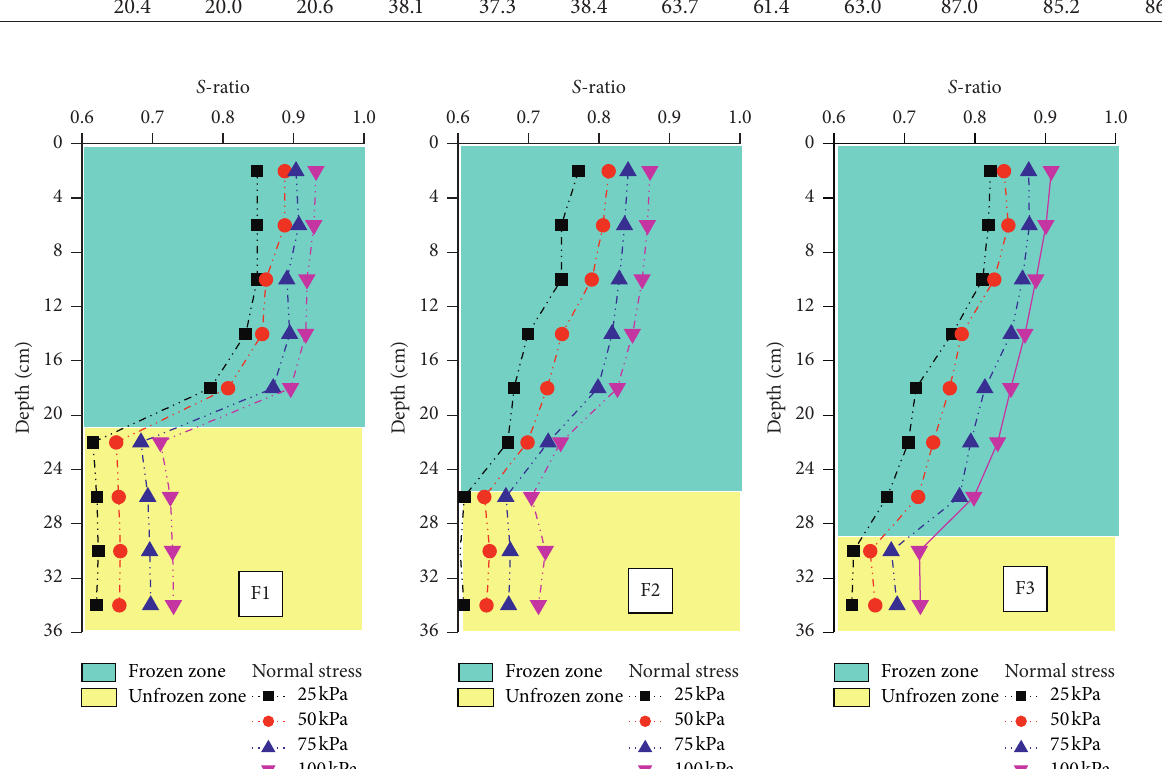
Figure 7: Shear strength ratio ( S -ratio) at the expansive soil columns’ different depths after the different freeze-thaw